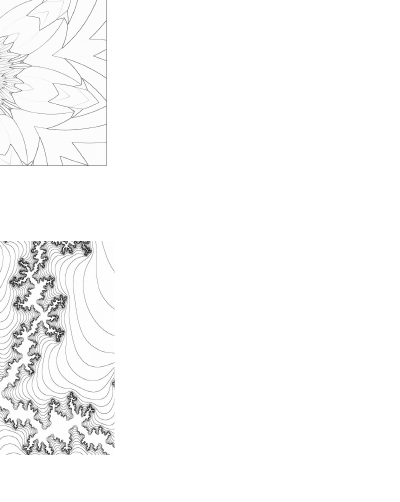
Figure 17. ( a – c ) Three coloring pages from Fractal Art Coloring book by Doug